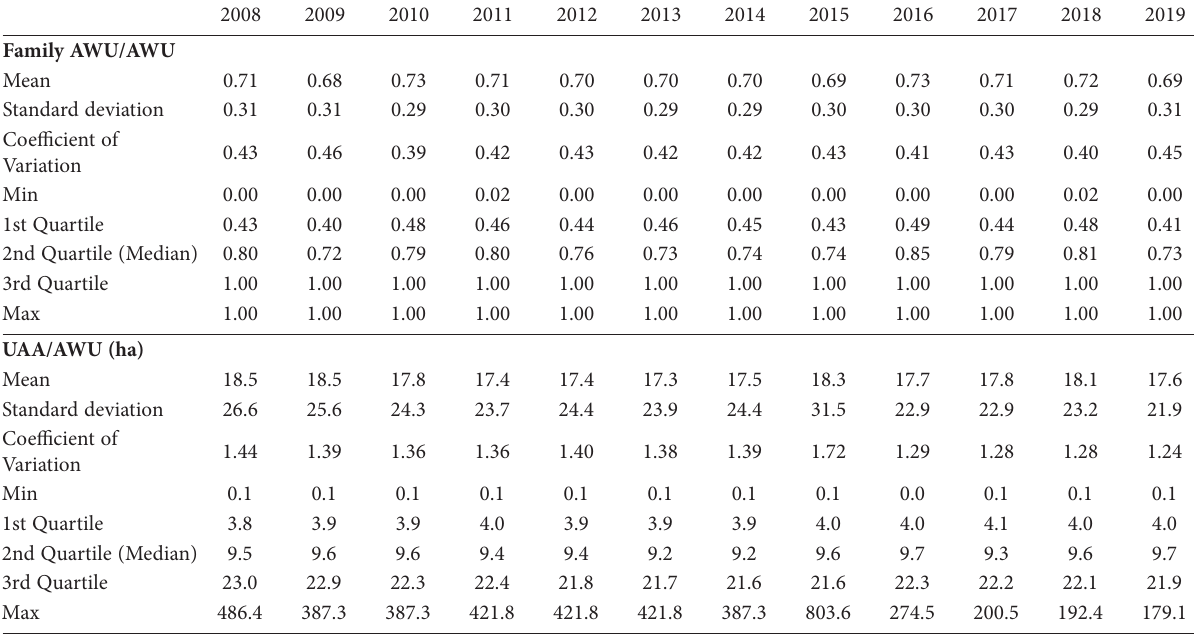
Table A2.Factor use and profitability per labour unit within the Italian 2008-2019 FADN balanced